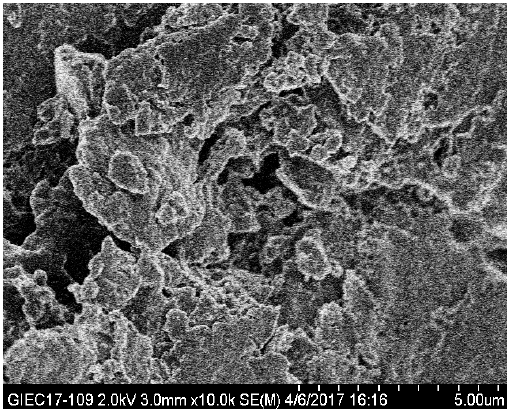
Figure 10. SEM image of the composite.